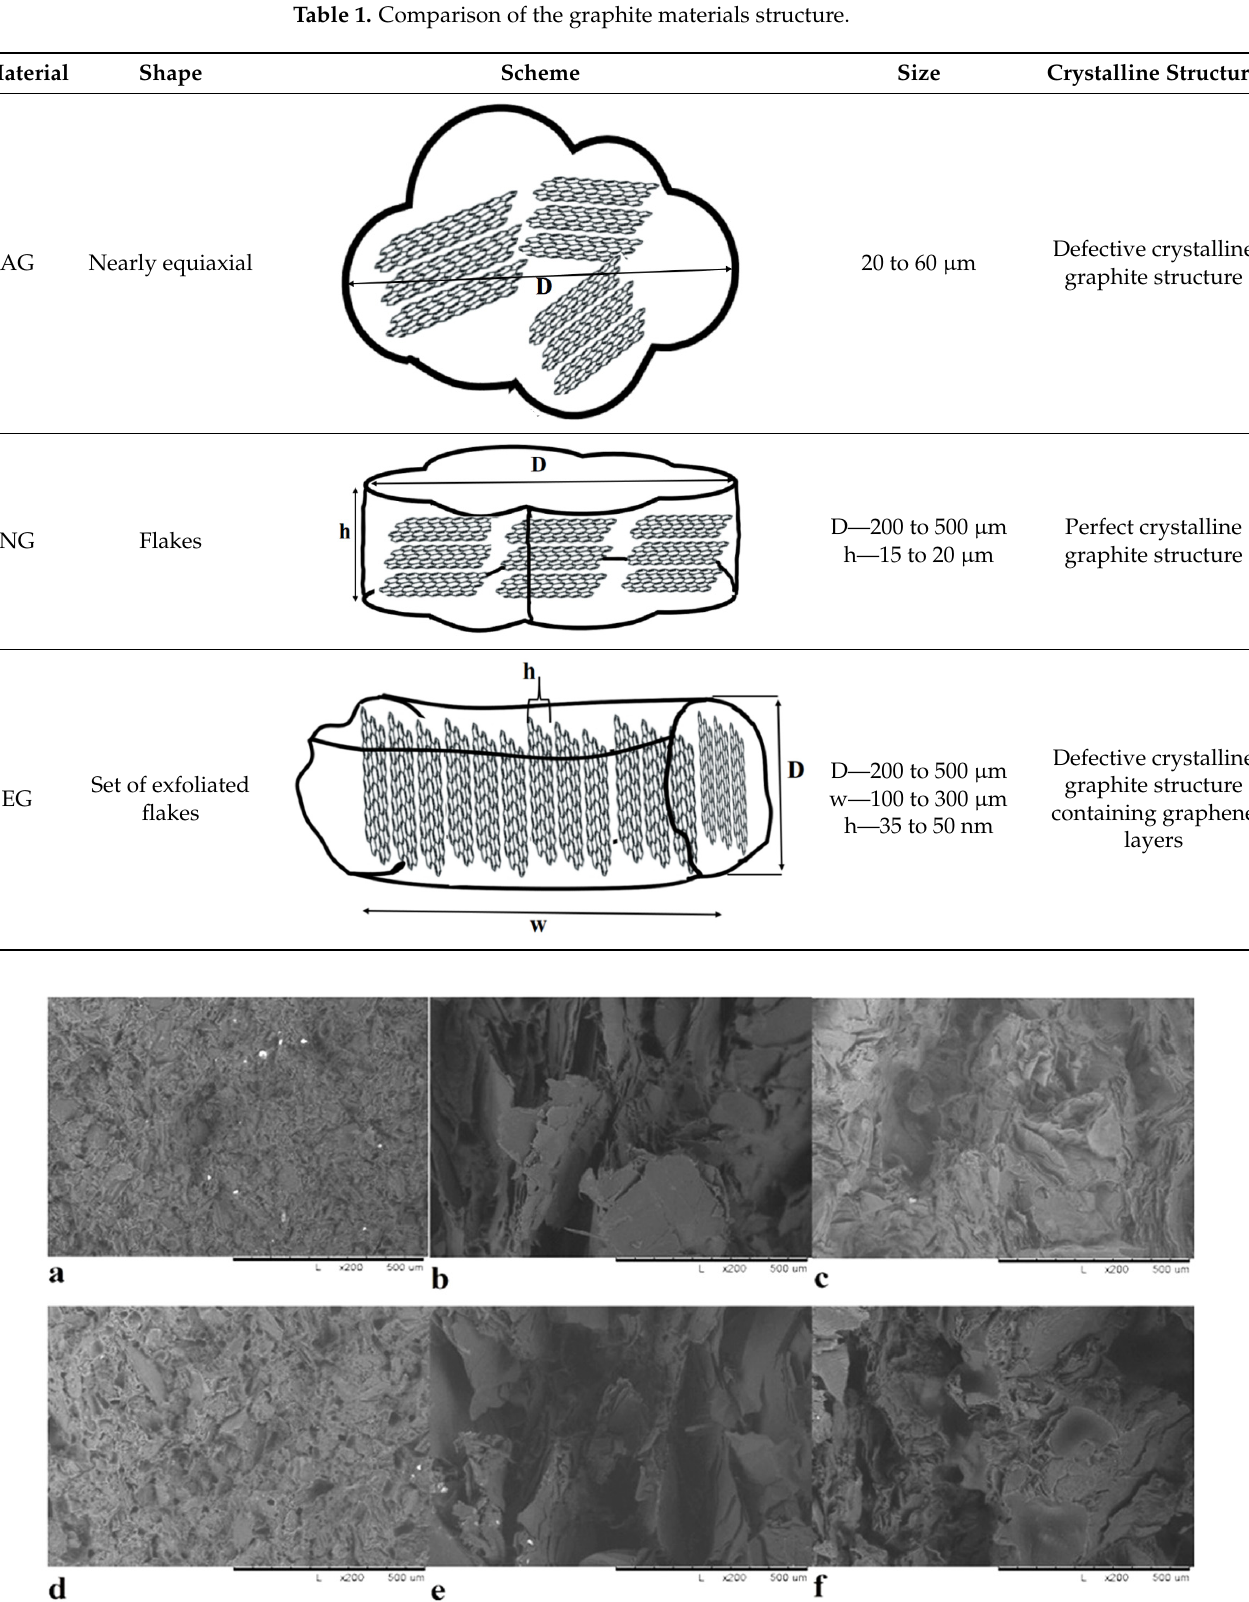
Figure 5. SEM micrographs of: polysulfone (PSU) + 50 wt.% AG ( a ); PSU + 50 wt.% NG ( b ); PSU + 50 wt.% EG ( c ); PSU + 70 wt.% AG ( d ); PSU + 70 wt.% NG ( e ); PSU + 70 wt.% EG ( f ).